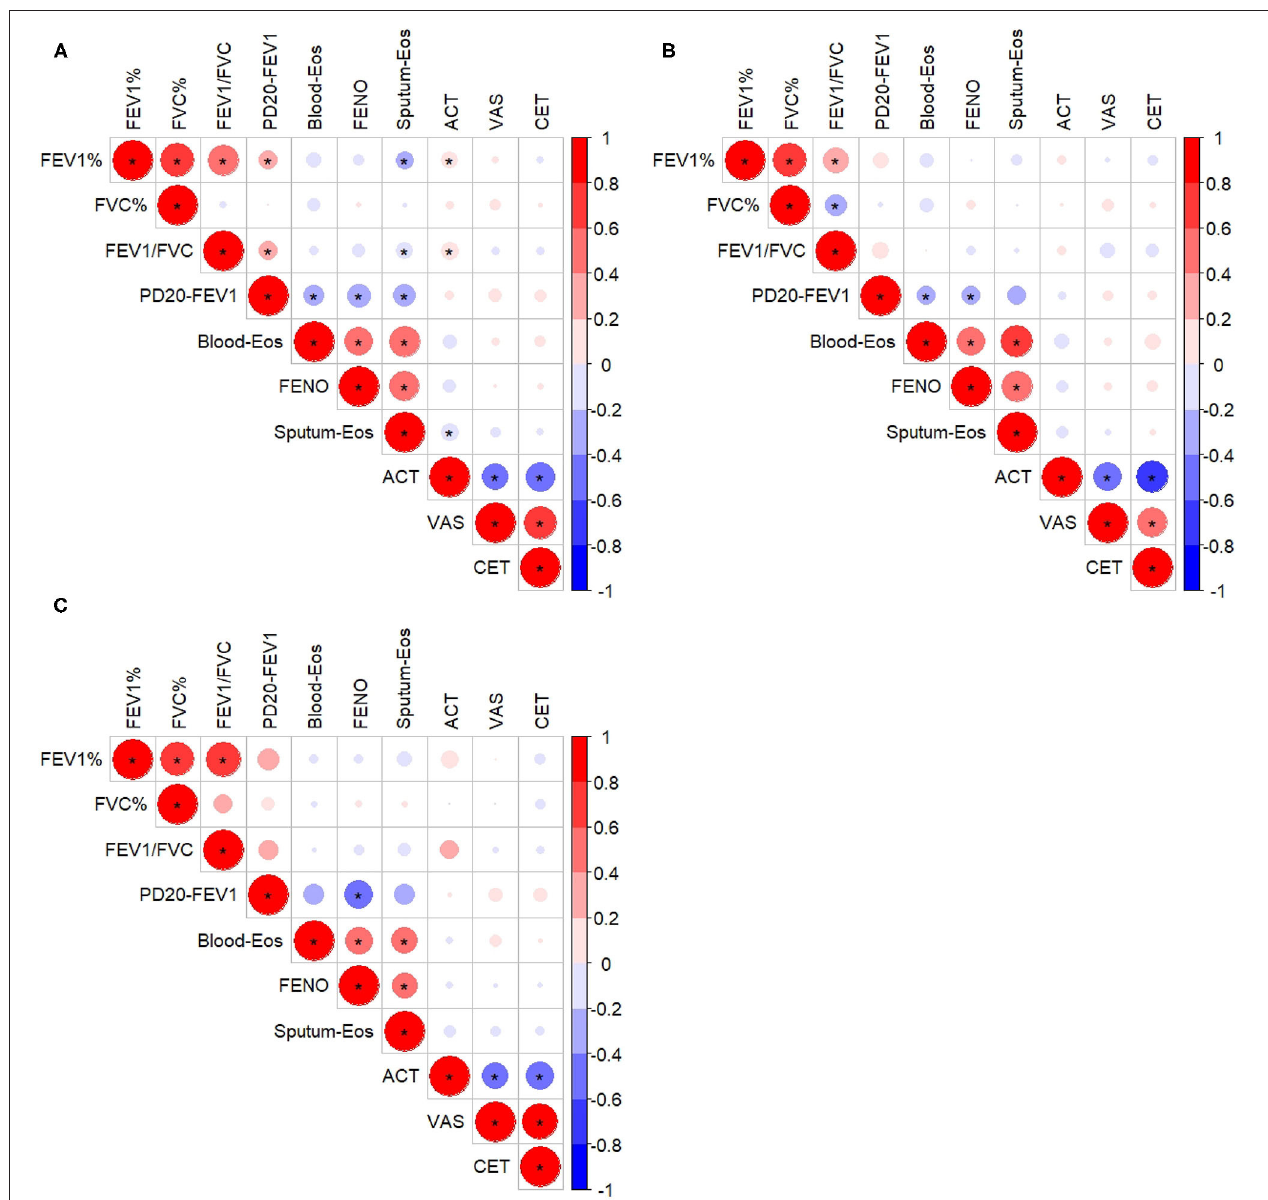
FIGURE 3 | Correlation among inflammatory indexes, lung function, and questionnaire assessments in all the subjects (A) , the subjects with cough variant asthma (B) , and the subjects with classic asthma (C) . * Refers to p < 0.05. FEV1%, forced expiratory volume in 1s, % predicted; FVC, forced vital capacity, % predicted; Blood-Eos, blood eosinophil count; FENO, fractional exhaled nitric oxide; Sputum-Eos, sputum eosinophil count; ACT, asthma control test; VAS, cough visual analog scale; CET, cough evaluation test; PD20-FEV1, provocative cumulative dose of methacholine causing a 20% fall in FEV1. The size of the circle and the intensity of the color represent the correlation coefficient, with the larger size and deeper color indicating a higher correlation coefficient value; a red color indicates a positive correlation, while blue color indicates a negative